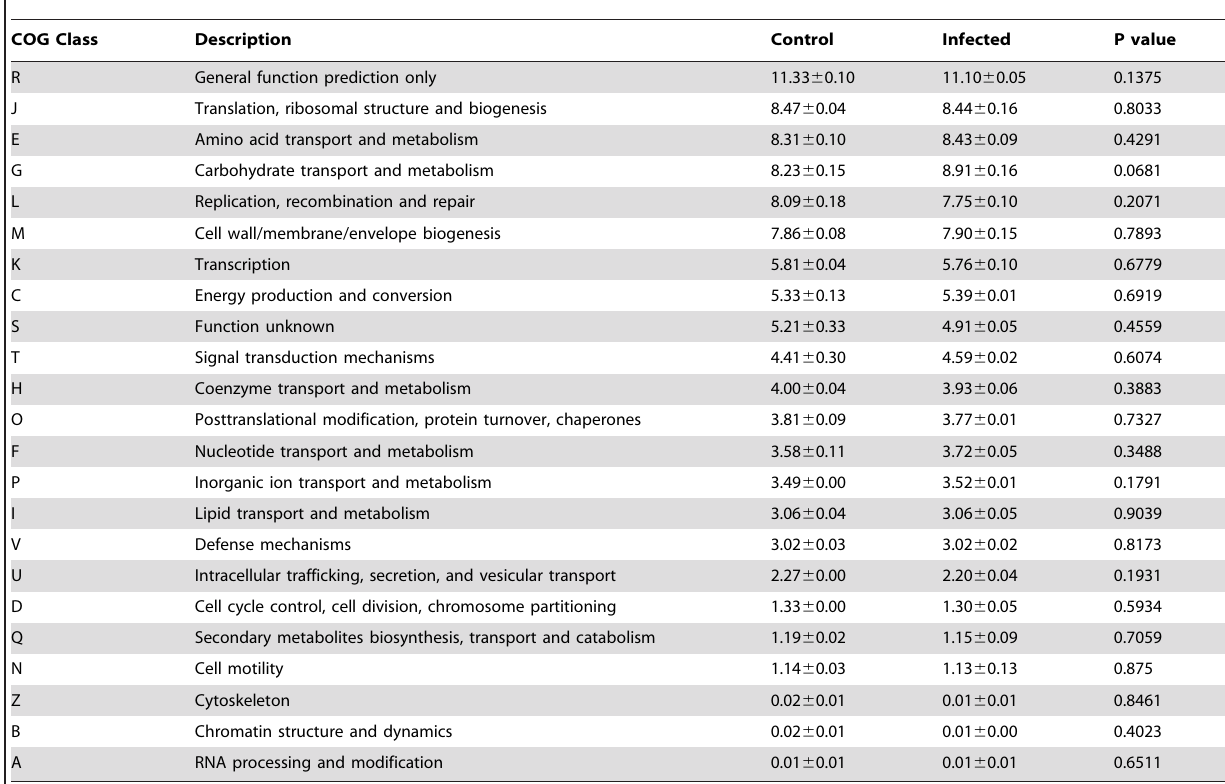
Table 2. COG function classes identified in the bovine abomasal microbiota of immune